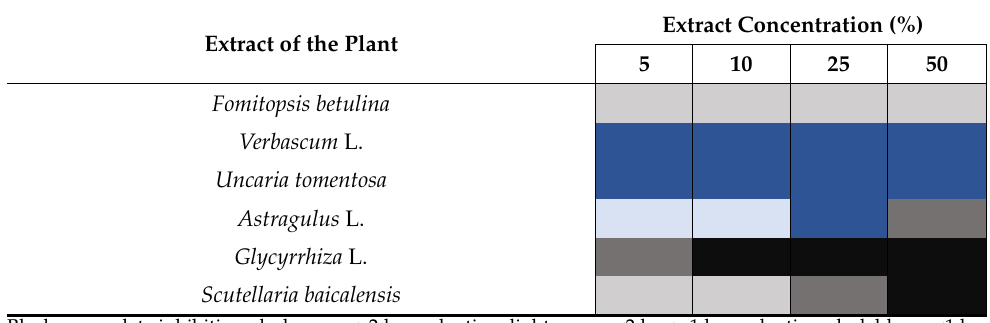
Extract Concentration (%)